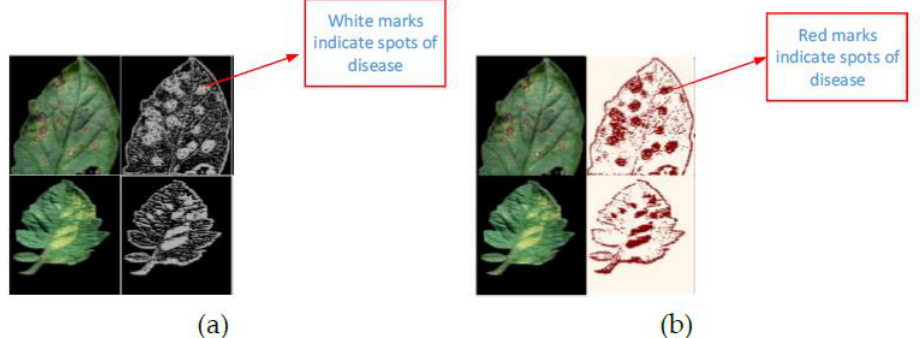
Figure 8. ( a ) Teacher / student architecture approach; ( b ) segmentation using a binary threshold algorithm [67] .